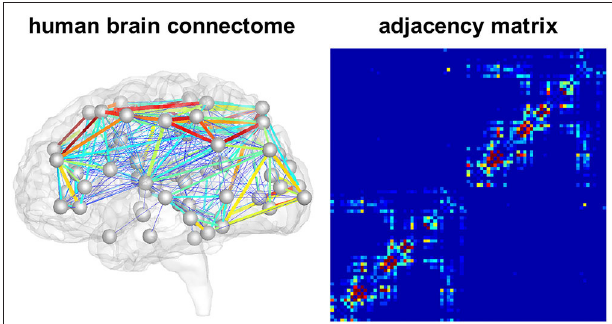
FIGURE 2 | Brain network model. Connectivity-weighted brain network and corresponding adjacency matrix. Colors represent the connection strength between two regions. Connectivity is moderate to strong within the two brain hemispheres while there are only few and weak connections between